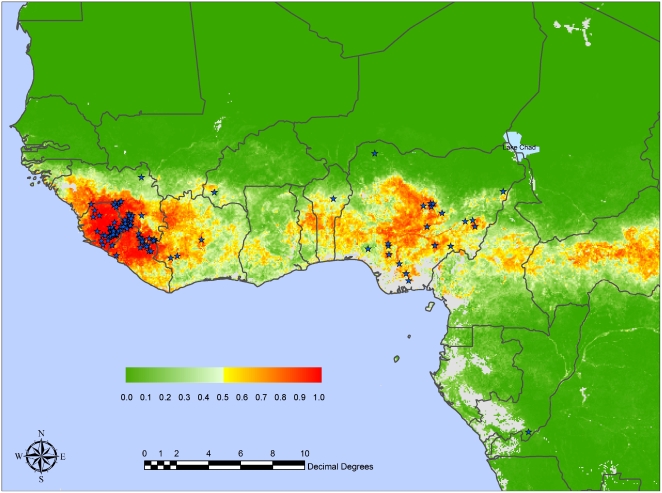
Mean predicted Lassa risk map for West Africa from the Model 2 series with two absence and one presence clusters, with positive localities indicated by stars.The posterior probability colour scale, from 0.0 (no risk) to 1.0 (highest risk) is shown as an inset. Grey areas are either areas with no suitable imagery (because of cloud contamination; coastal Nigeria and Cameroon) or else are so far from any of the training set sites in their environmental conditions that no predictions are made for them.